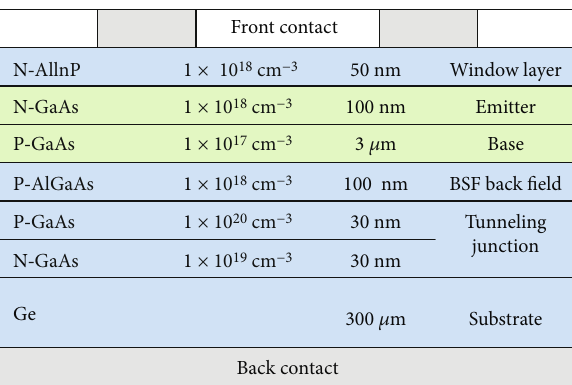
Figure 1: Schematic diagrams of GaAs/Ge cells used in the study.